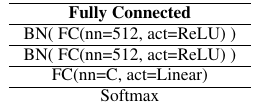
Table 3. Architectures of the Fully Connected Classification